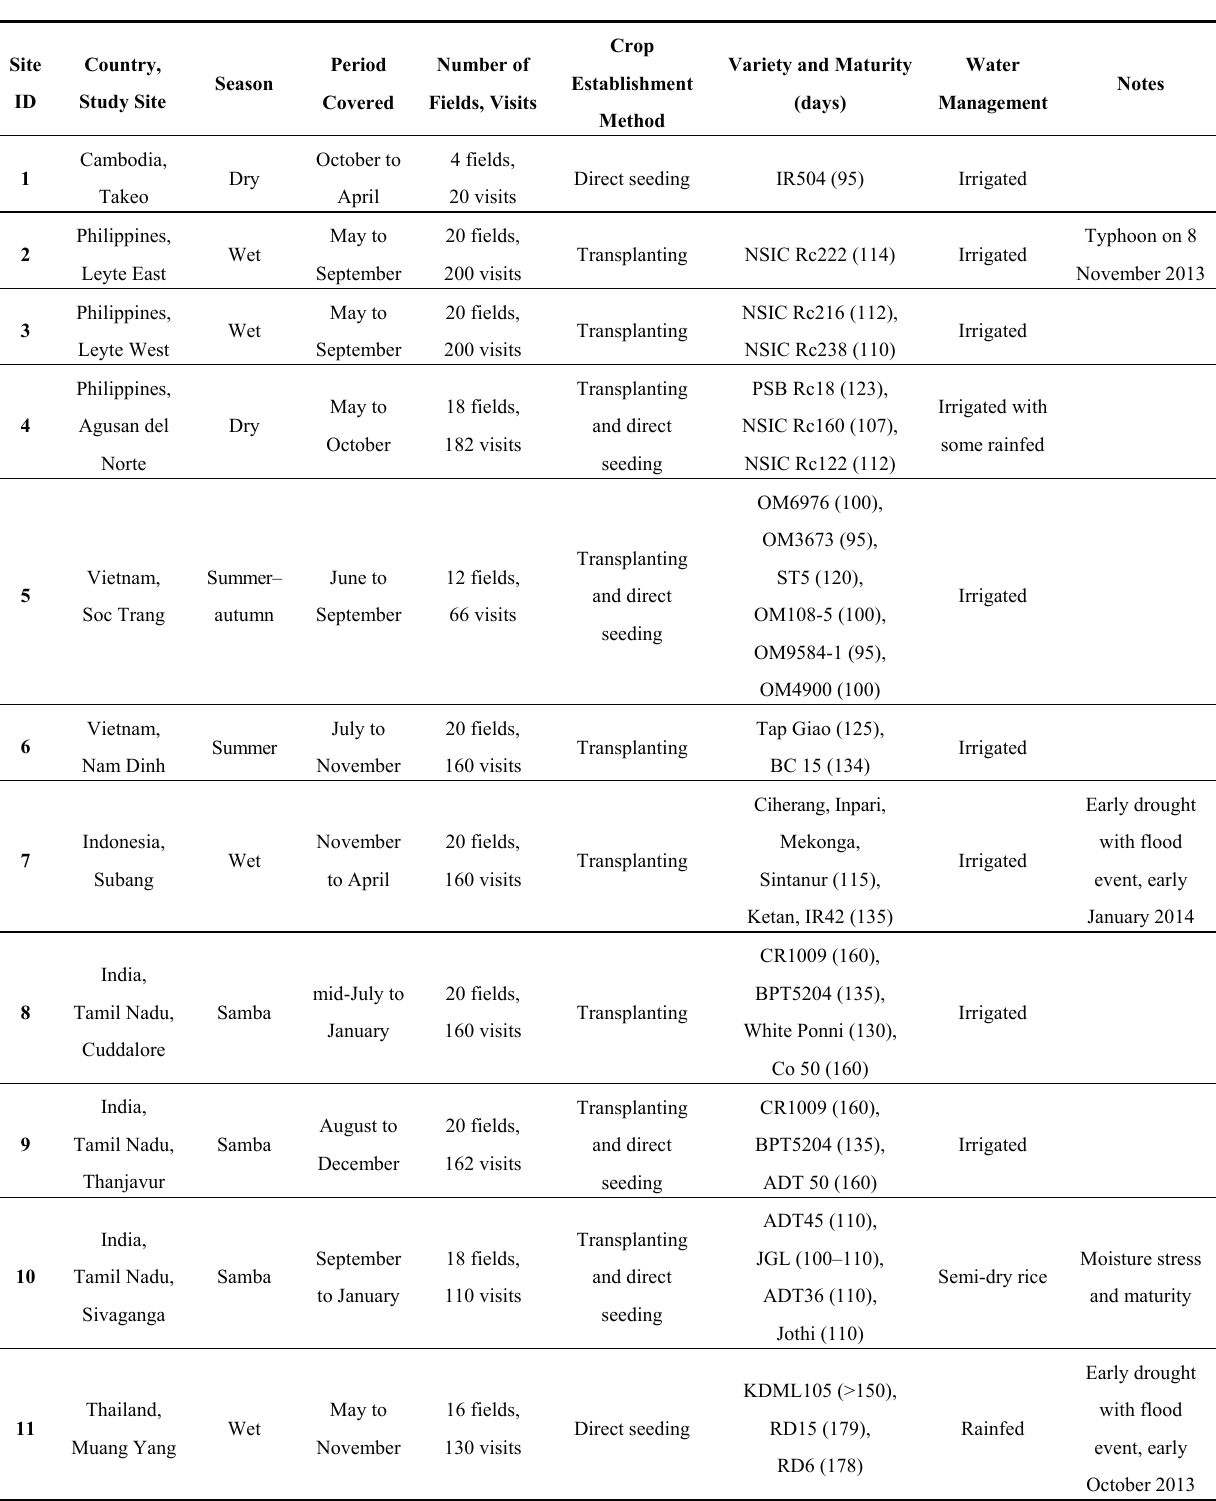
Table 2. Summary of site visits and observed rice crop characteristics during the monitored